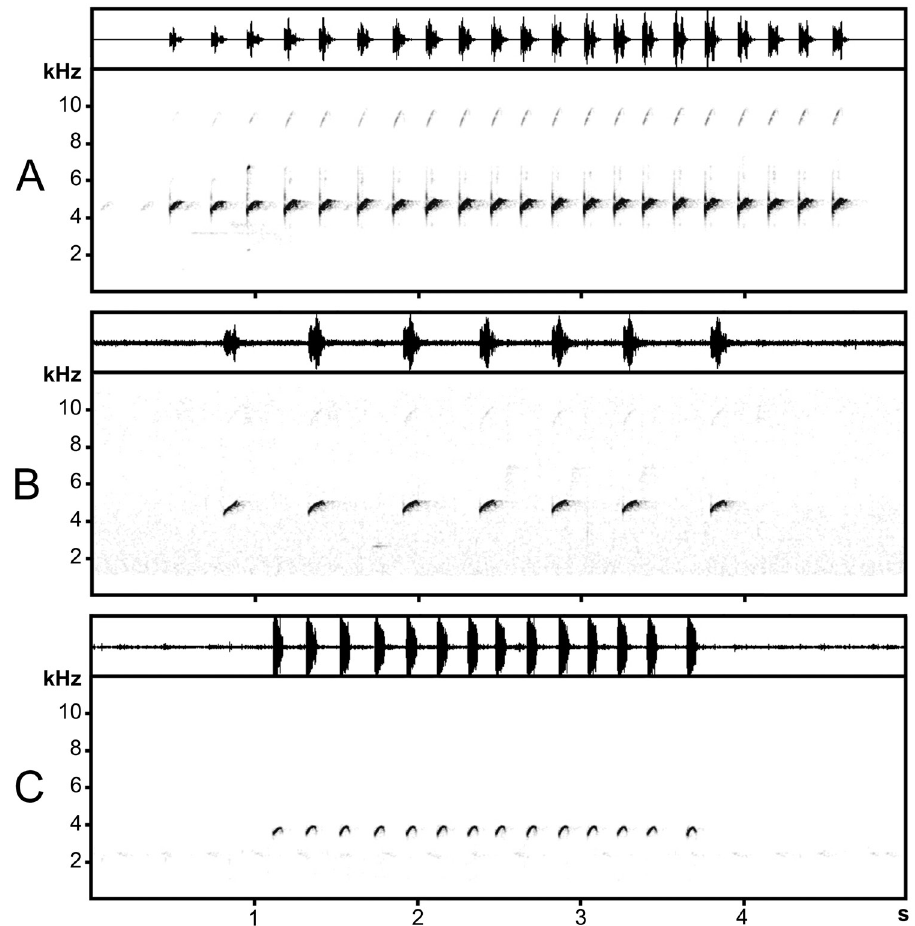
Figure 5. Oscillograms (top) and sonograms (bottom) of male advertisement calls of A Ophryophryne elfina sp. n. ( Lam Dong Prov. , Bidoup -Nui Ba N.P., 1935 m a.s.l., 17°C) B O. gerti (Dak Lak Prov., Chu Yang Sin N.P., 1020 m a.s.l., 22°C) C O. synoria (Dak Lak Prov., Chu Yang Sin N.P., 750 m a.s.l., 21°C). The sampling rate lowered to 22.05